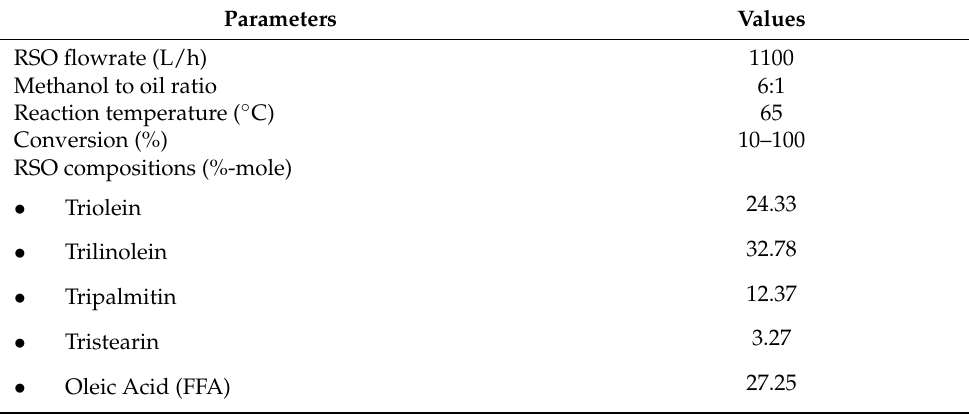
Table 4. RSO to biodiesel simulation parameters.